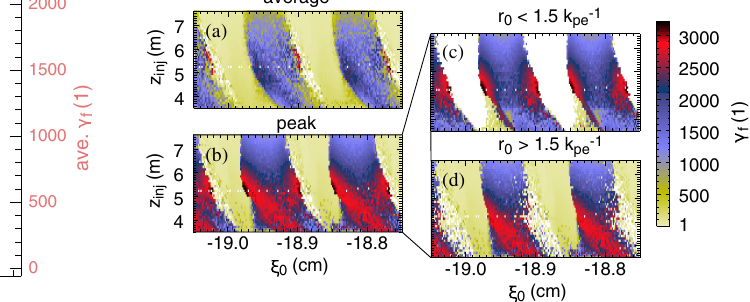
FIG. 10. Maximum (blue) and average (pink) final energies for each row of the 1D diagnostic graphs in Fig. 8(a) (solid lines) and PIC simulation results 8(b) (dashed lines) as a function of the injection point z . inj